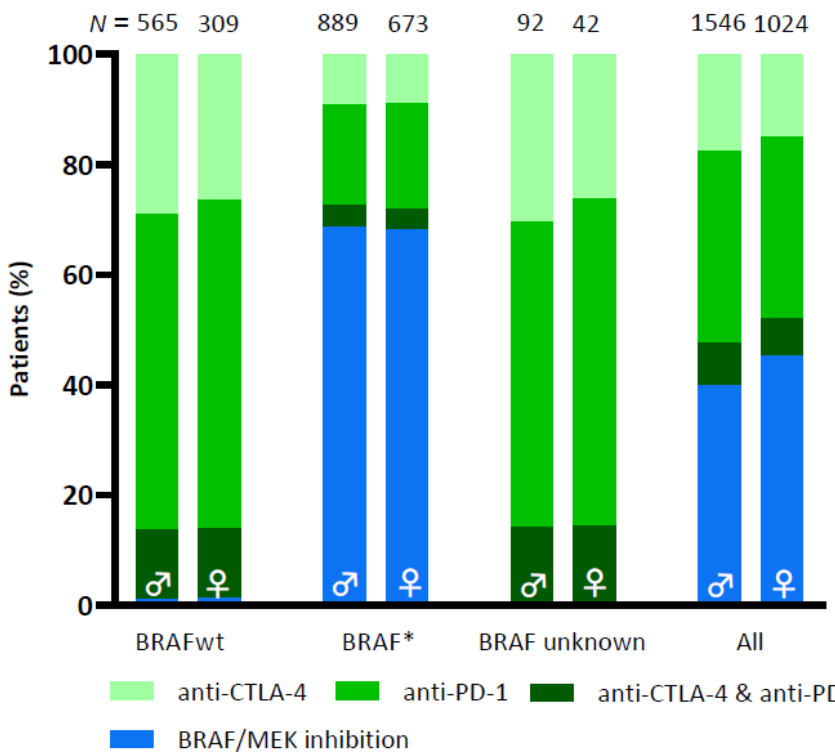
Figure 2. Initial systemic treatment with immune checkpoint inhibition and targeted therapy in male and female patients. “*”: mutation.